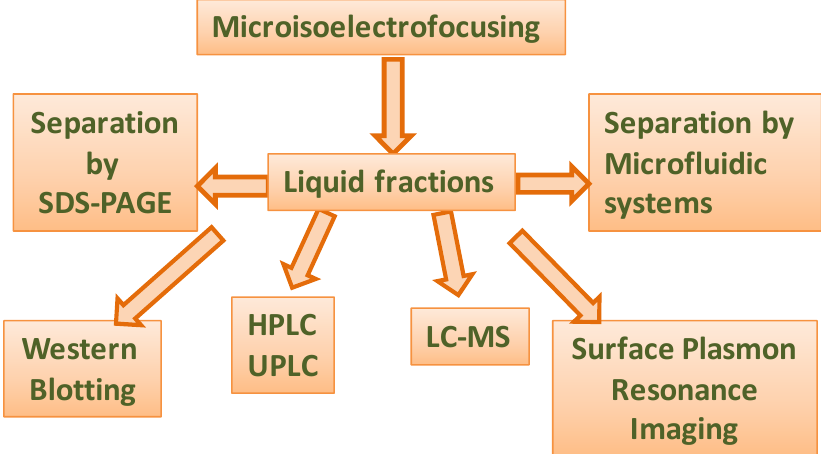
Figure 5. Some examples of analysis after